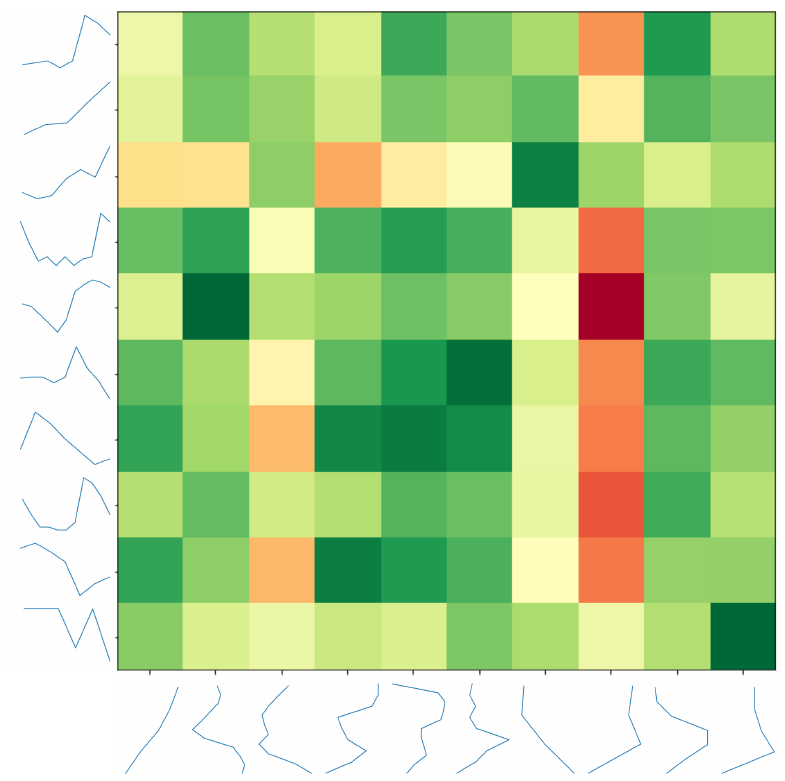
Figure 12. A pairwise distance matrix between discovered shapelet sets of two different